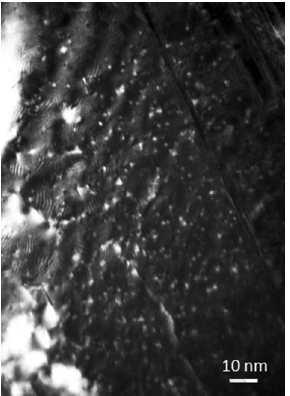
Figure 1. Stacking fault tetrahedra formed in Cu. The sample was deformed at room temperature with a strain rate of 10 6 /s. Dark-field weak-beam TEM observation along [110] direction.